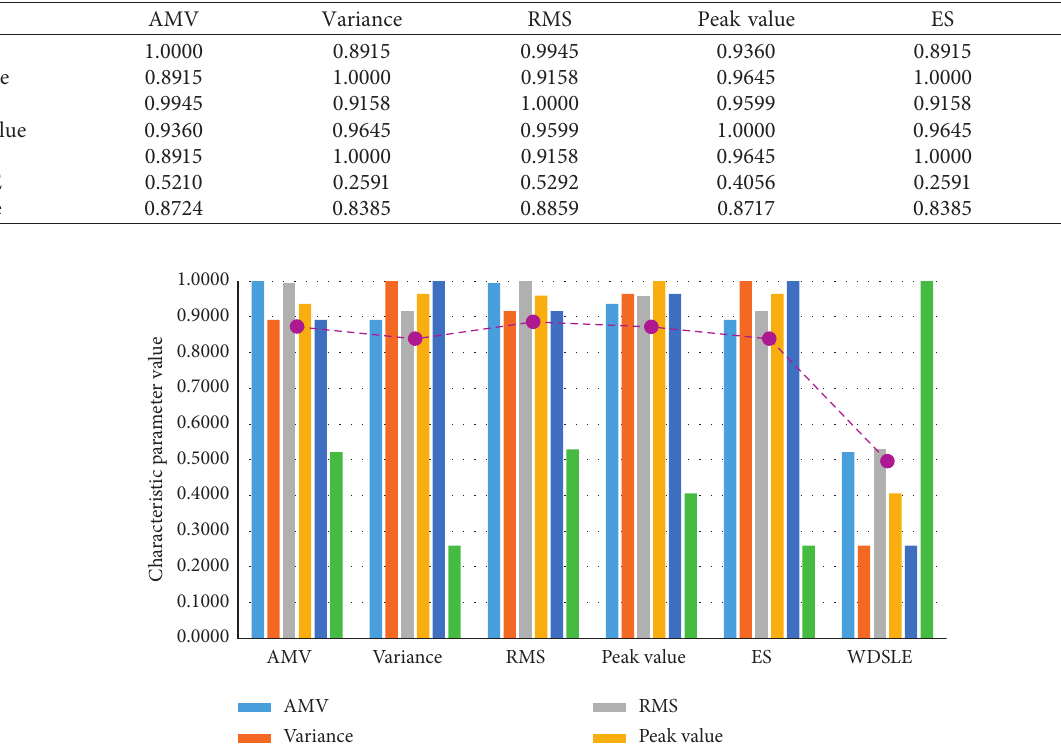
Table 1: Table of consistency indicator value for six characteristic parameters.